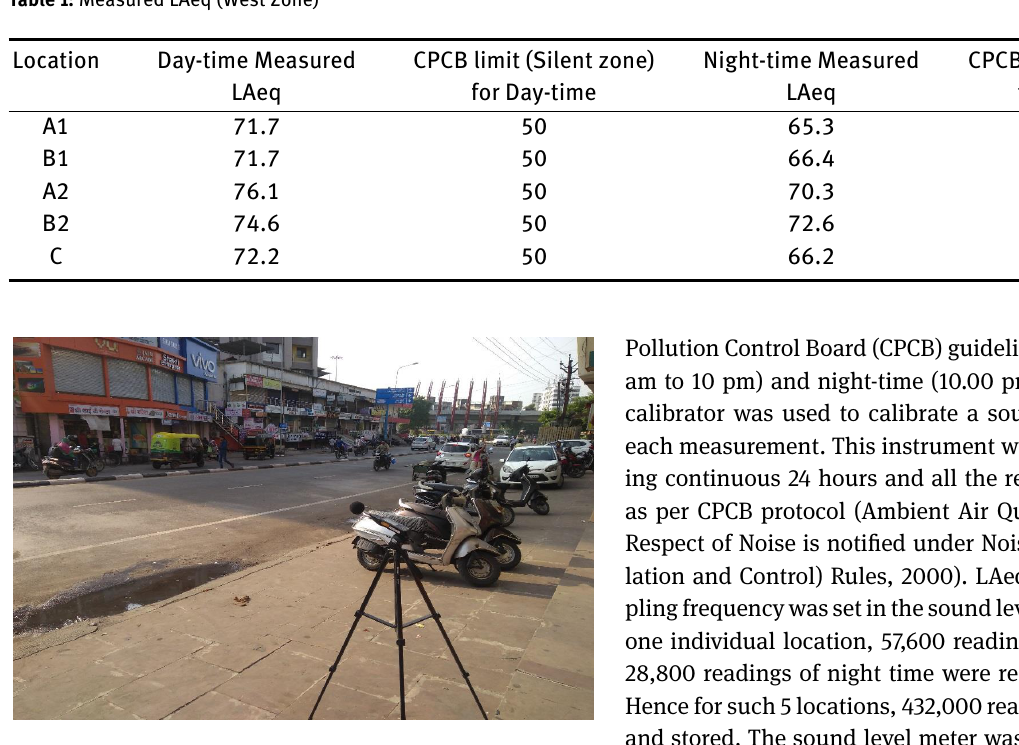
Table 1: Measured LAeq (West Zone)